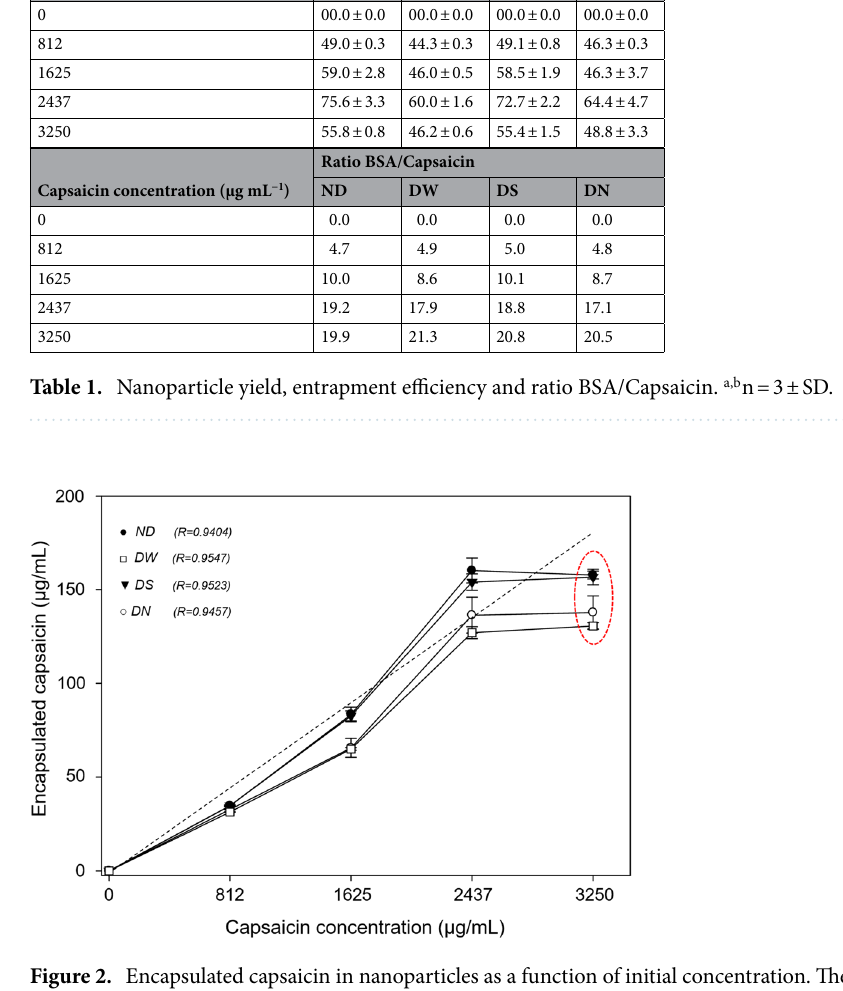
Figure 2. Encapsulated capsaicin in nanoparticles as a function of initial concentration. The quantified capsaicin showed a linear tendency followed by a plateau for all drying treatments. Values are means of three experimental replicates ± standard